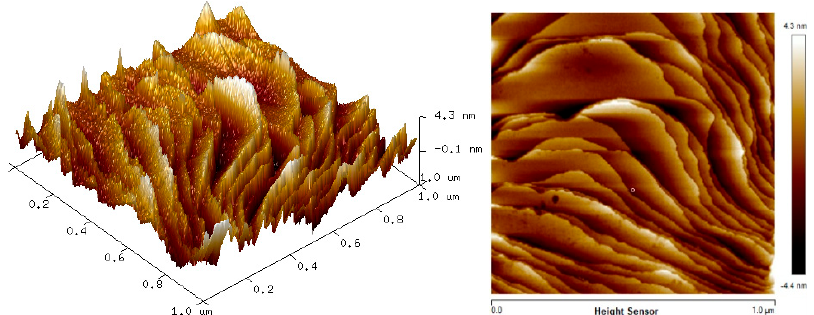
Figure 5. Atomic force microscope (AFM) images of CTAB thin film.